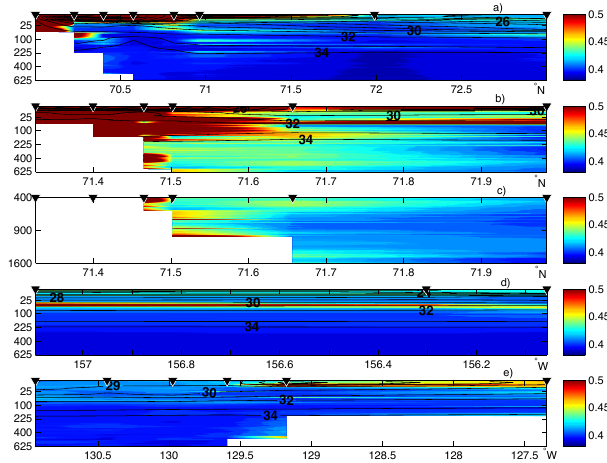
Fig. 7. A comparison of the beam attenuation coefficient (m − 1 ) along four different shelf-basin sections. All data are from the sum- mer of 2007. These are (a) the eastern Beaufort shelf region along the longitude 140 ◦ W, (b) the western Beaufort shelf region along the longitude 150–152 ◦ W. Here, the near-surface (1–625m) atten- uation features are shown (c) The deep attenuation features (400– 1600m) along the western Beaufort shelf, (d) The eastern North- wind Ridge slope region along the latitude 75–76 ◦ N, and (e) the eastern shelf of the Canada Basin region along the latitude 73– 74 ◦ N. The vertical axis is nonlinear (square root). Black horizontal lines represent the isohalines with 1.0 salinity resolution and black triangles denote the station